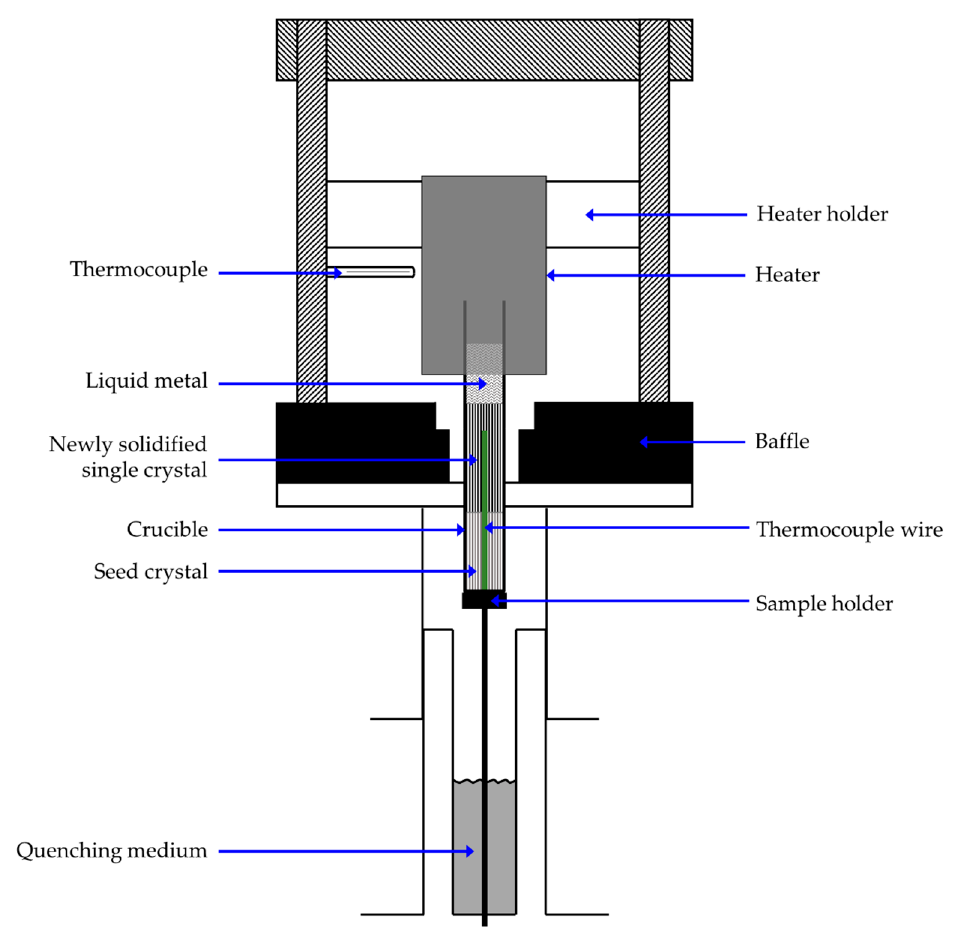
Figure 1. Schematic of the modified, laboratory-scale Bridgman-Stockbarger furnace.